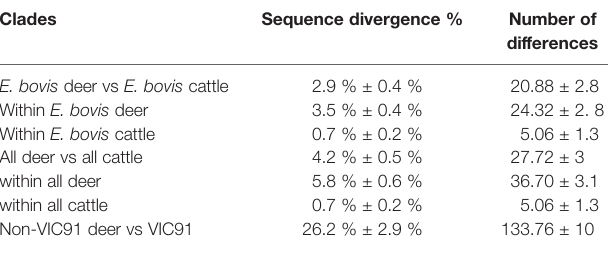
TABLE 2 | Mean sequence divergence and number of differences (nucleotides) between Australian deer and cattle sequences within clades. Clades